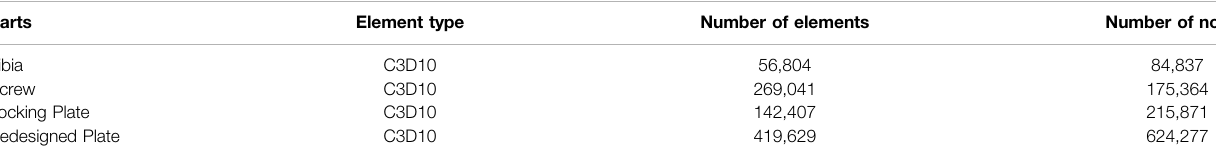
TABLE 1 | Types of elements, number of nodes, and number of elements in each part of the model. Parts Element type